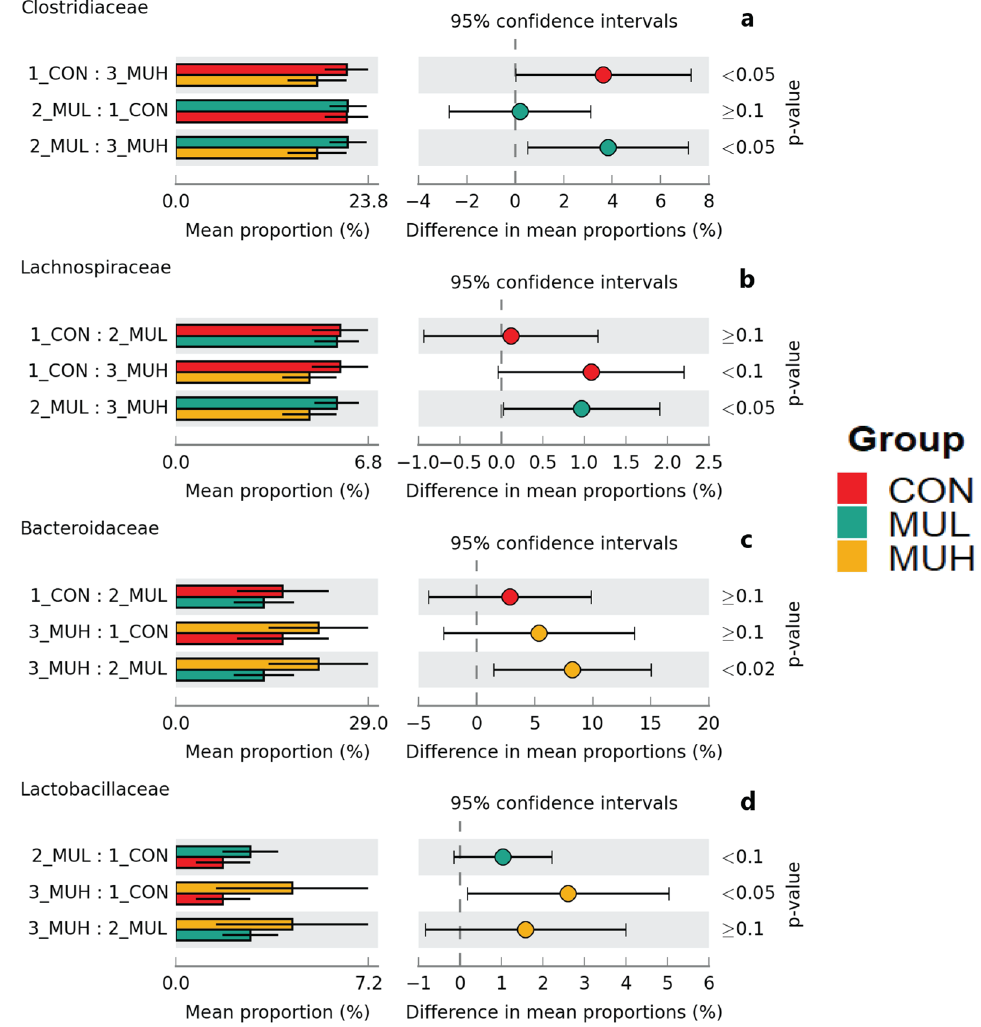
Figure 7. Extended error bar plots of mean relative abundance differences of caecal Clostridiaceae ( a ), Lachnospiraceae ( b ), Bacteroidaceae ( c ), and Lactobacillaceae ( d ) between CON, MUL, and MUH at slaughter (42 d). Colored bars and black lines indicate the mean relative abundance and standard deviation of the bacterial family, respectively (left side). Colored dots inside the 95% confidence intervals signify the difference of mean relative abundance of the bacterial family for each pairwise comparison (center). Games-Howell post-hoc test p -values are reported (right